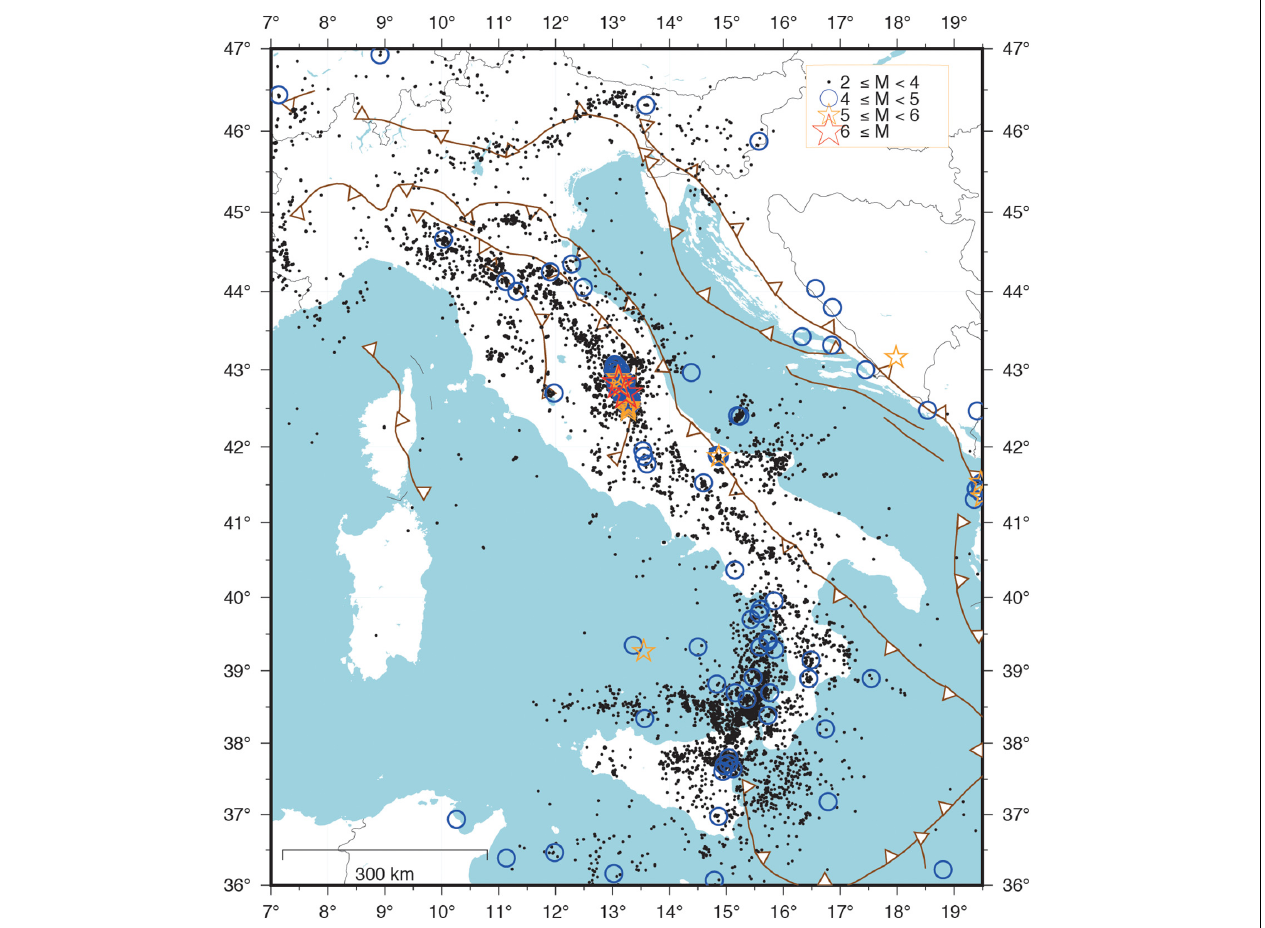
FIGURE 1 | Earthquakes, M ≥ 4.0 (blue circles), M ≥ 5.0 (orange stars), and M ≥ 6.0 (red stars), that occurred in the Italian region in the period 2015–2019. Small black dots are M ≥ 2.0 earthquakes. The main tectonic fronts of the region are reported in brown